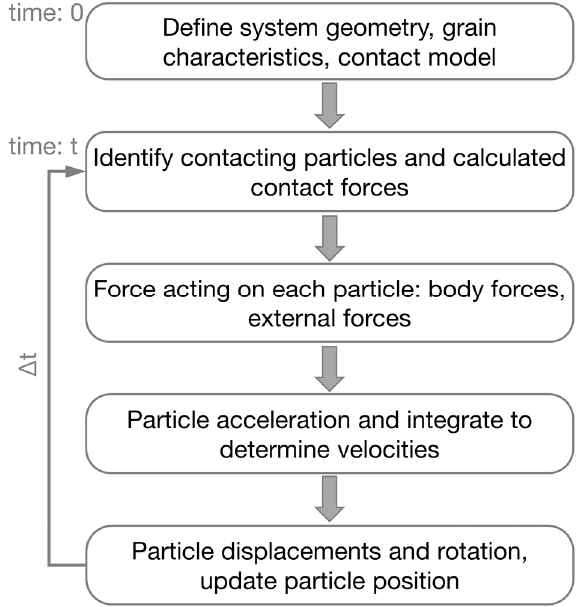
Figure 3. Calculation sequence within a DEM time step.